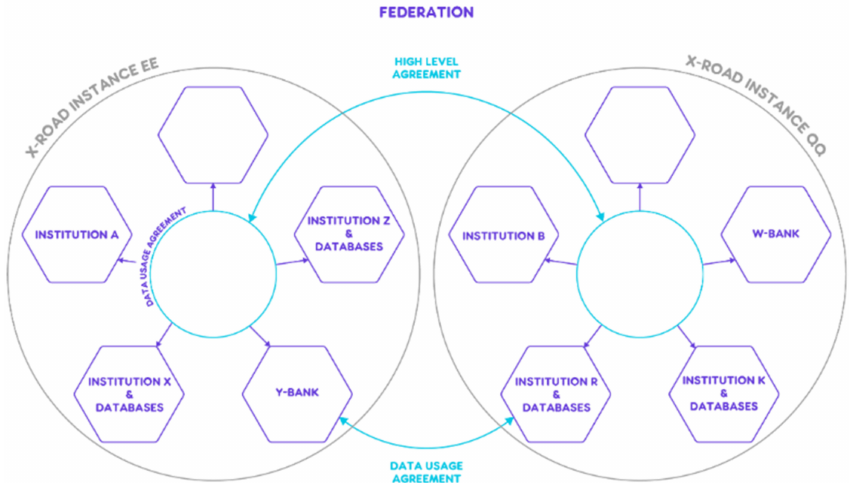
Figure 4. Federation of data platforms. Source: Estonian Information System